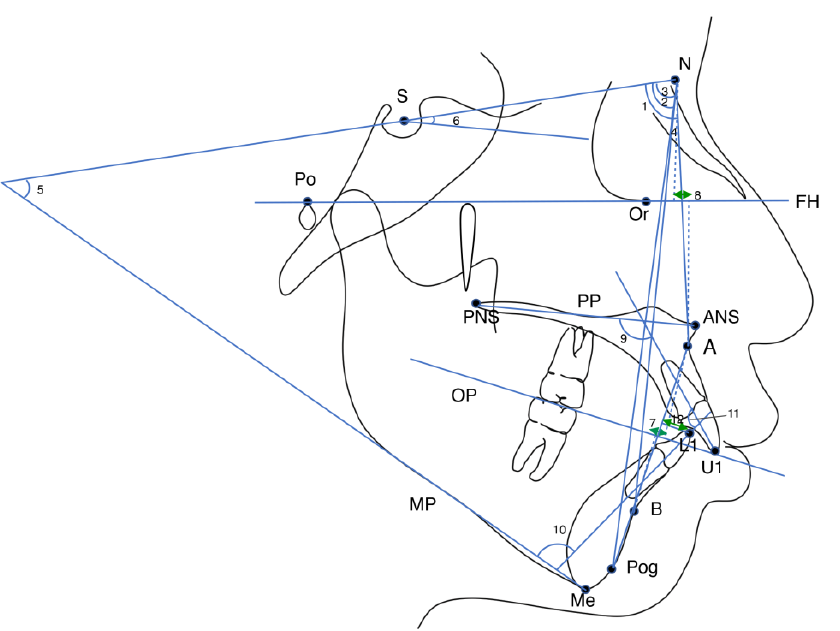
Figure 1. Cephalometric landmarks and skeletal and dental measurements: S, Sella; N, Nasion; Po, Porion; Or, Orbitale; ANS, anterior nasal spine; PNS, posterior nasal spine; A, Subspinale; B, Supramentale; Pog, Pogonion; Me, Menton; U1, tip of maxillary central incisor; L1, tip of mandibular central incisor; FH, Frankfort horizontal plane; PP, palatal plane (ANS-PNS); OP, occlusal plane; MP, mandibular plane.